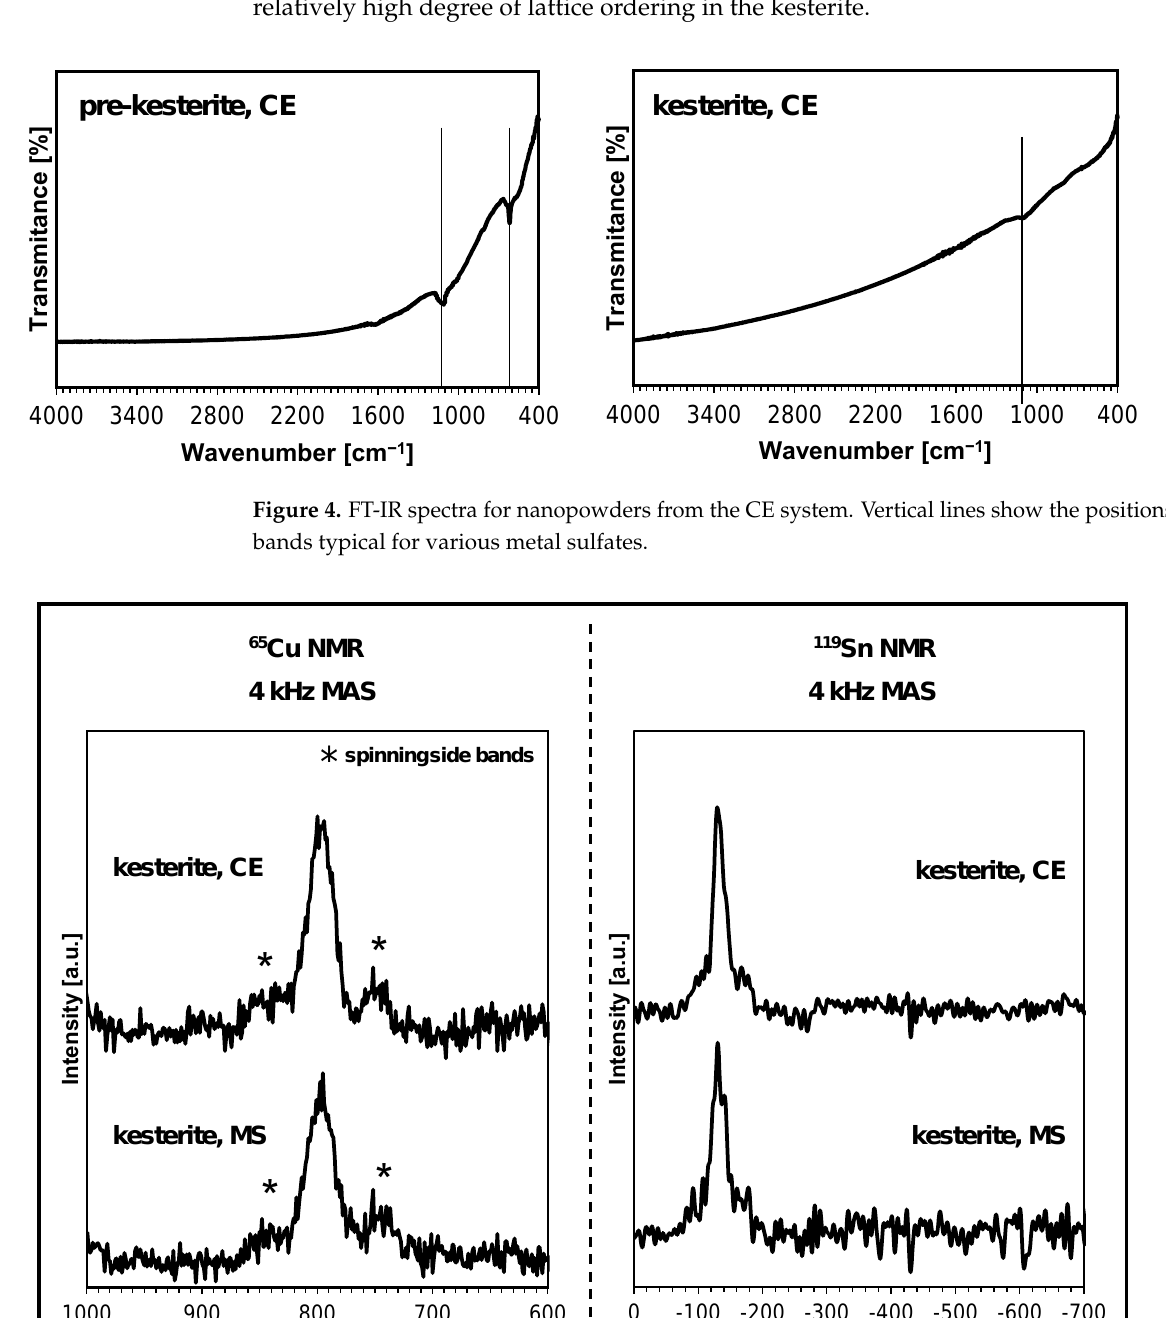
Figure 3. Raman spectra for the nanopowders from the CE system ( top row) and MS system ( bottom row). Vertical lines indicate the approximate positions of kesterite-specific Raman bands.